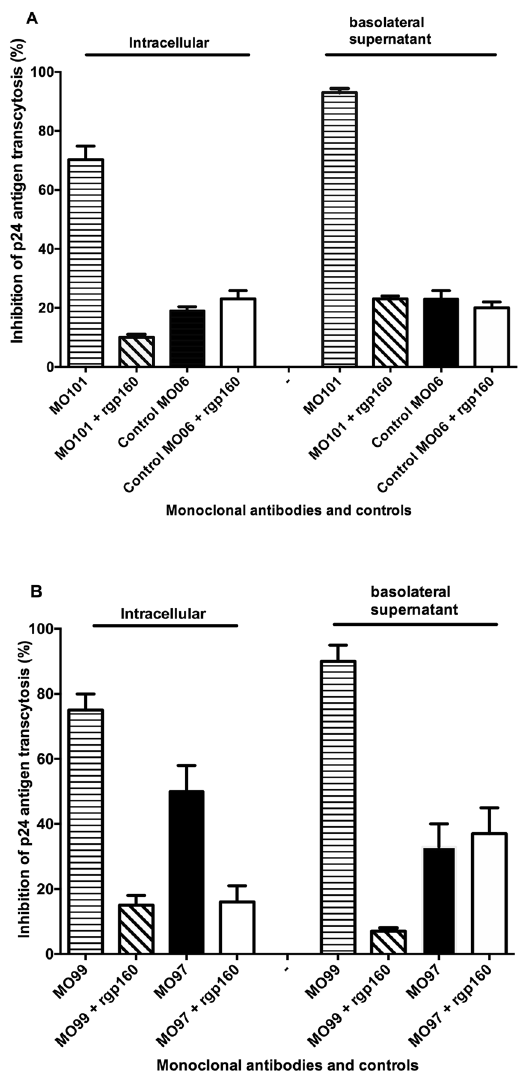
Figure 4. Inhibition of transcytosis of infectious HIV-1 by human anti-HIV-1 env IgM monoclonal antibodies. The in vitro neutralizing Human anti-HIV-1 IgM MO101, MO97, and MO99 and the control non-neutralizing MO6 with or without 5 µ g/mL rgp160 were added together with HIV-1 SI 6794 infected PBMC during 24 h on the apical side to assess inhibition of HIV-1 transmission/transcytosis from the apical side to the basolateral side across the human epithelial cell line Caco-2-pIgR + . The inhibition of HIV transcytosis was assessed intracellularly in the cells and in the basolateral supernatant by p24 ELISA. ( A ) The in vitro neutralizing Human anti-HIV-1 IgM MO101 and the control non-neutralizing MO6 with or without rgp160 (p < 0.01), ( B ) the in vitro neutralizing anti-HIV-1 IgM MO99 (p < 0.01) and MO97 (p = 0.05) with or without rgp160. Mann Whitney U test was used to determine if the samples were significantly different than the negative control ( ** p < 0.01.and * p < 0.05). The bars represent the median percent and range inhibited HIV-1 p24 antigen in vitro from two to three repeated experiments. Comparisons of inhibited HIV-1 p24 were performed between control IgM (MO6) and the anti-HIV-1 neutralizing IgM